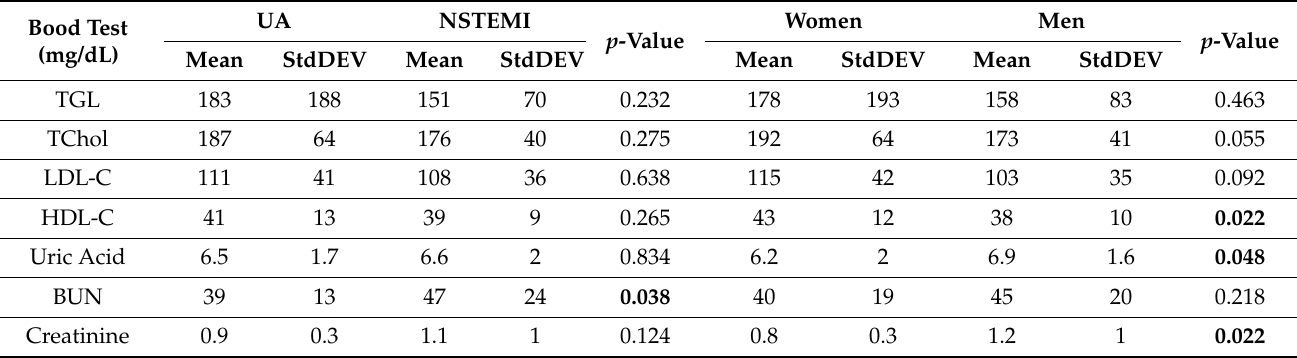
Table 2. Laboratory tests and student t -test p -values for independent variables.